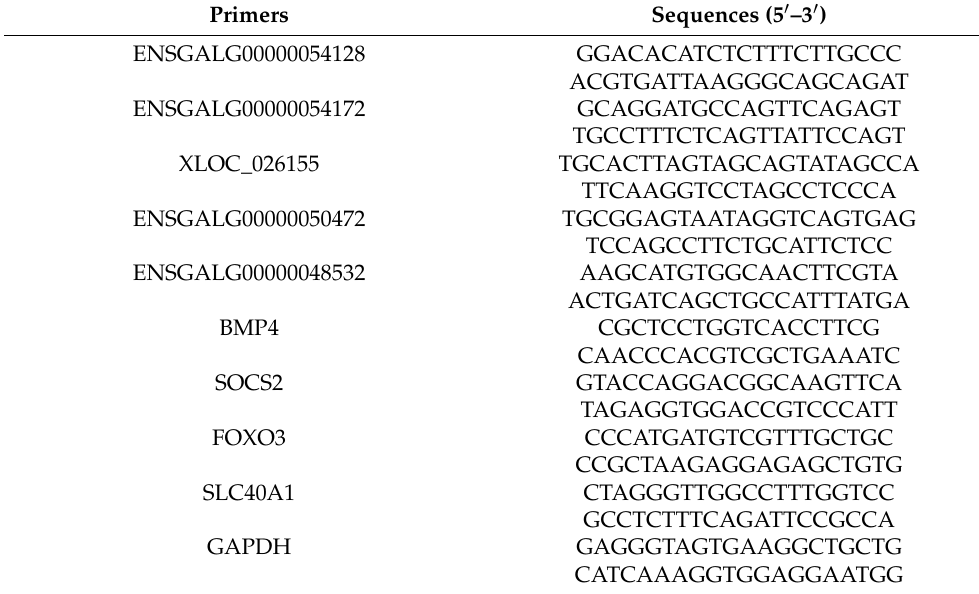
Table 1. Primers used in this